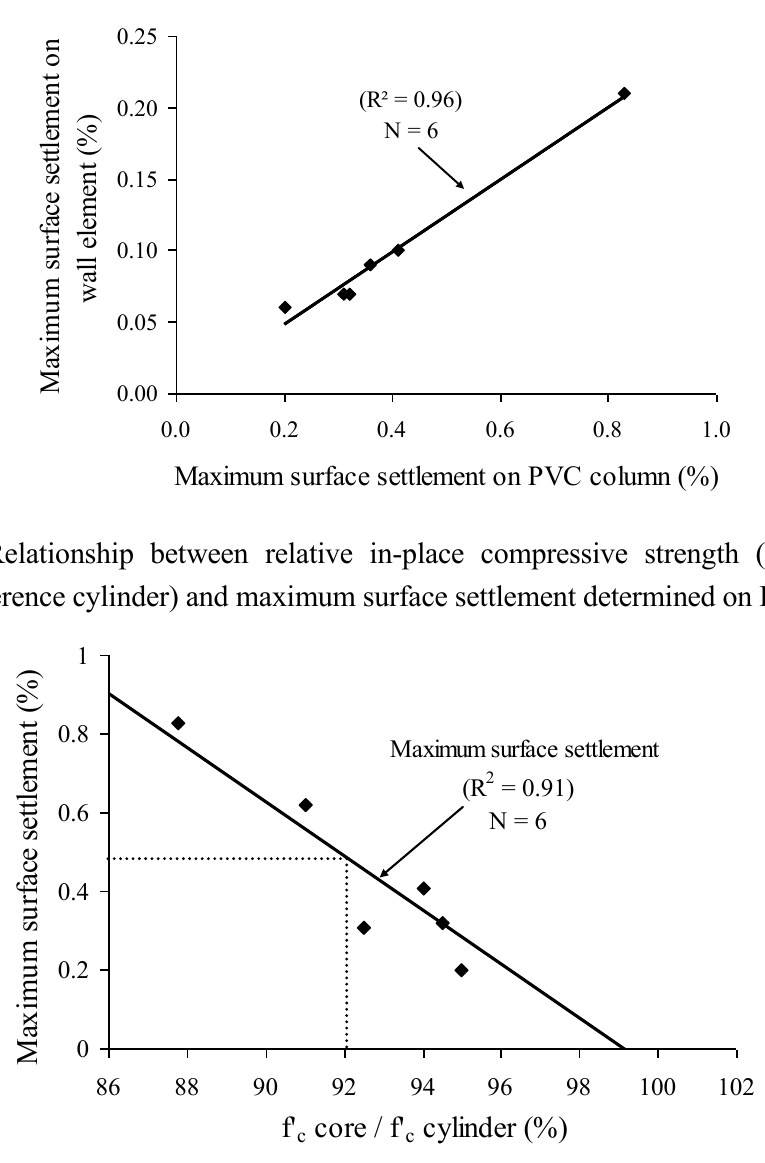
Figure 13. Relationship between surface settlement results determined on PVC columns and wall elements.